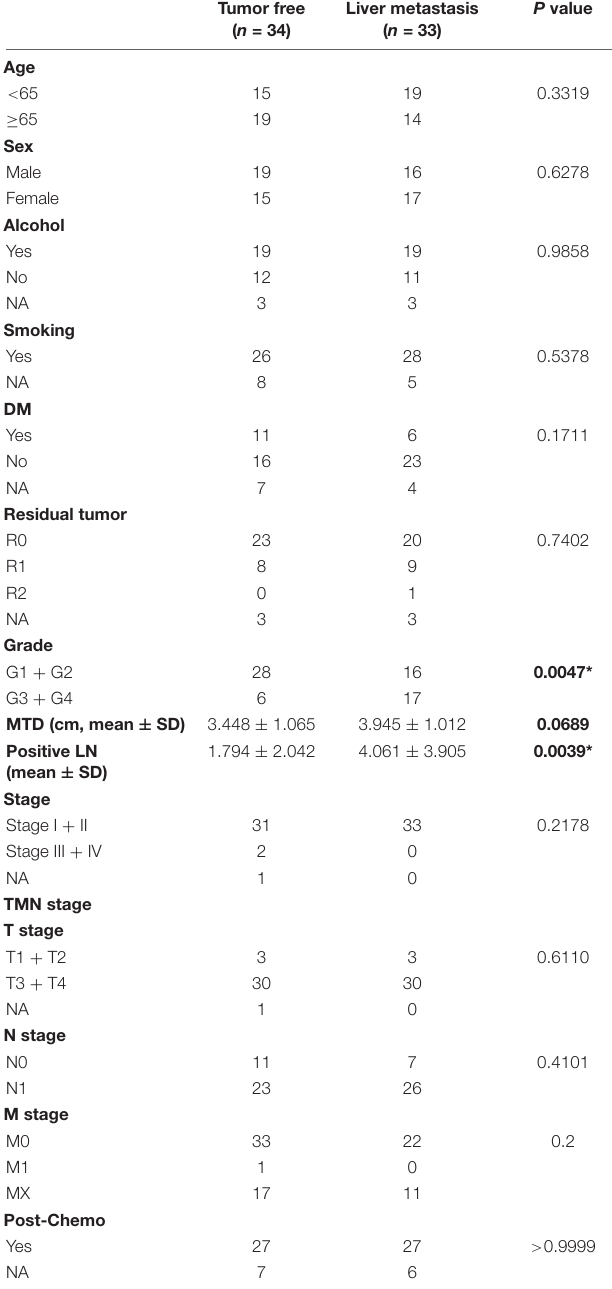
TABLE 2 | Patient baseline characteristics from